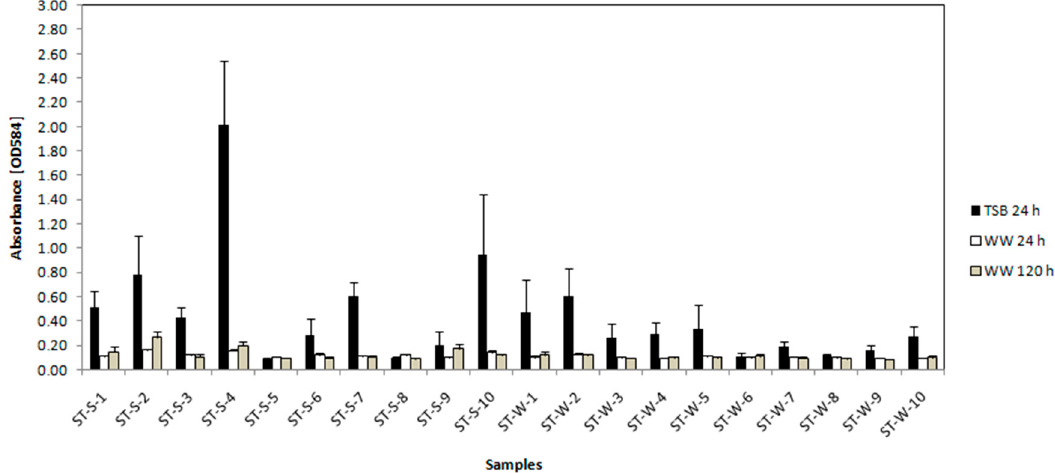
Figure 3. Biofilm formation of isolates from the sedimentation tank of wastewater treatment plant incubated in tryptic soy broth (TSB) and sedimentation wastewater (WW). Bacterial biofilm measured at 584 nm after 24-h and 120-h incubation at 30 °C. Table 2. Biofilm formation, hydrophobicity, autoaggregation and motility of isolates from the nitrification tank and sedimentation tank of wastewater treatment plant. TSB-tryptic soy broth; WW—wastewater; 5, 24 and 120 h—time of incubation; NP—non-producer. Little superscript letters in individual columns indicate correlation between parameters ( p <